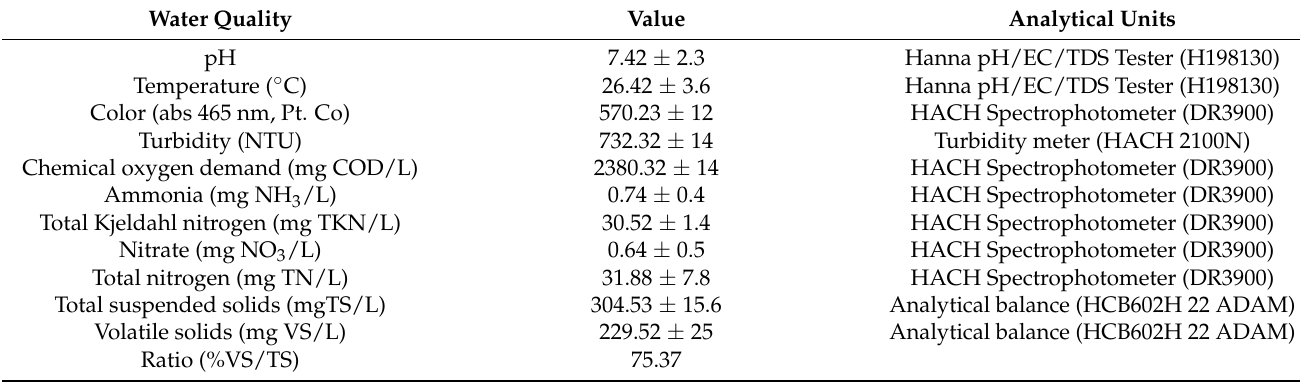
Table 1. Wastewater characteristics and analytical technique.